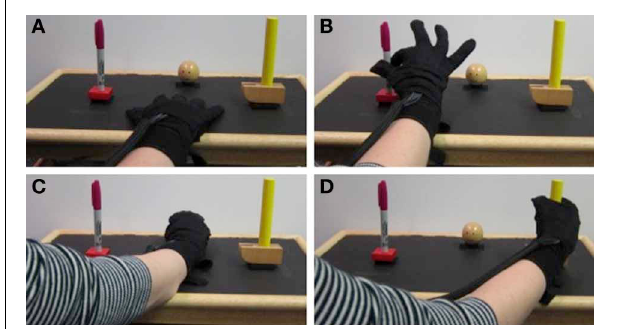
FIGURE 2 | Experiment setup. Kinematics were recorded with a 5DT Data Glove while the subject (AE trials) or experimenter (AO trials) grasped 3 objects placed on a tray. The rest position is shown in (A) . Pinch, power, and cylindrical grasps are shown in (B–D)